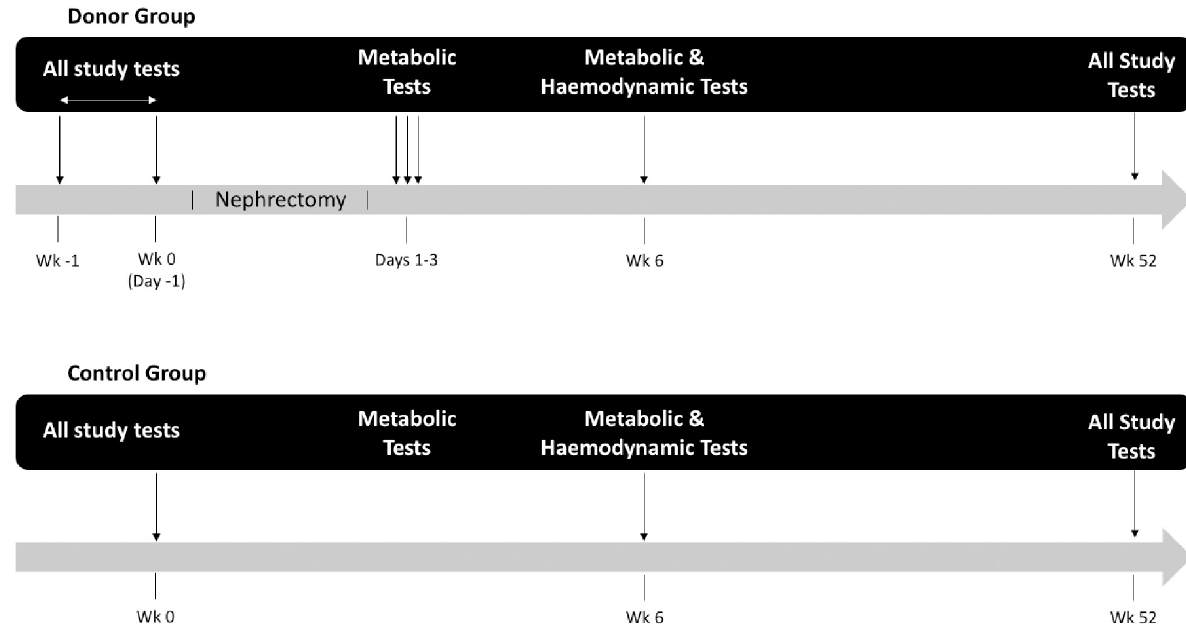
Fig 1. The KARMA study